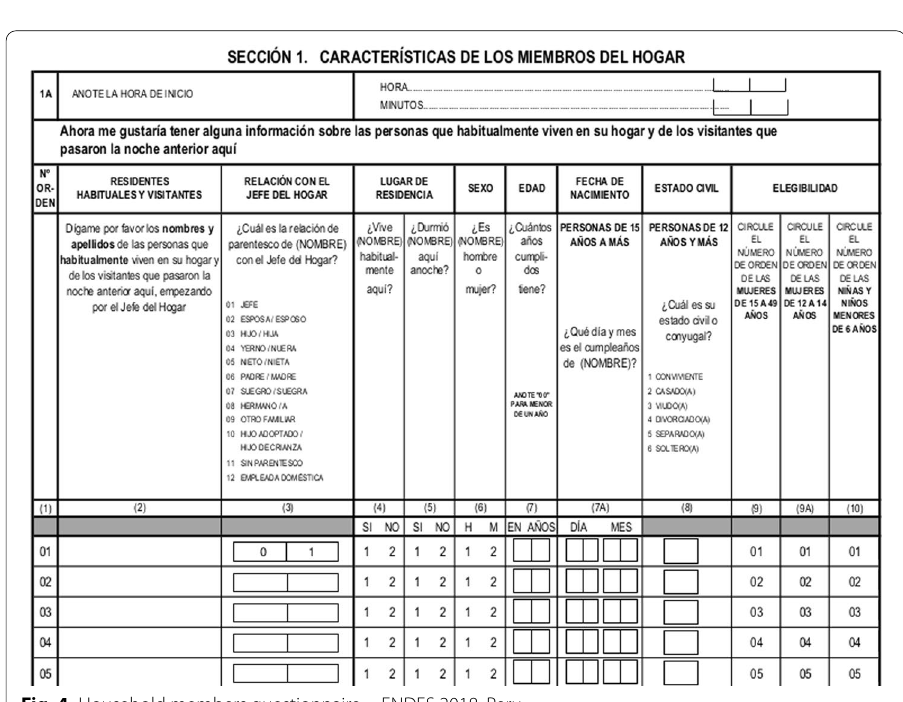
Fig. 4 Household members questionnaire—ENDES 2018,